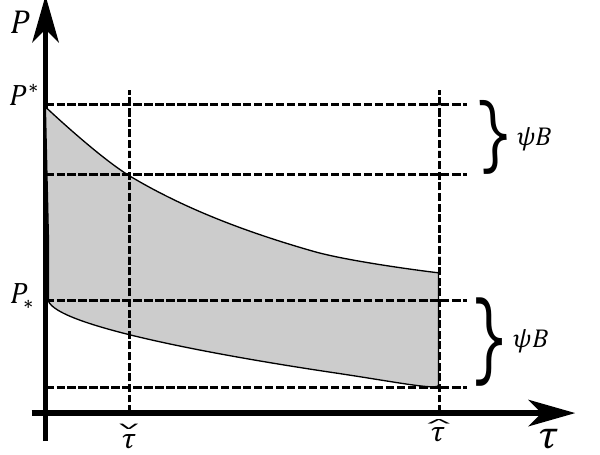
Figure 2. Shape of Ω : The upper and lower bound of Ω are given by characteristic curves, originating in ( 0, P ∗ ) and ( 0, P ∗ ) . The points P ∗ resp. P ∗ are constructed in such a way that the characteristics